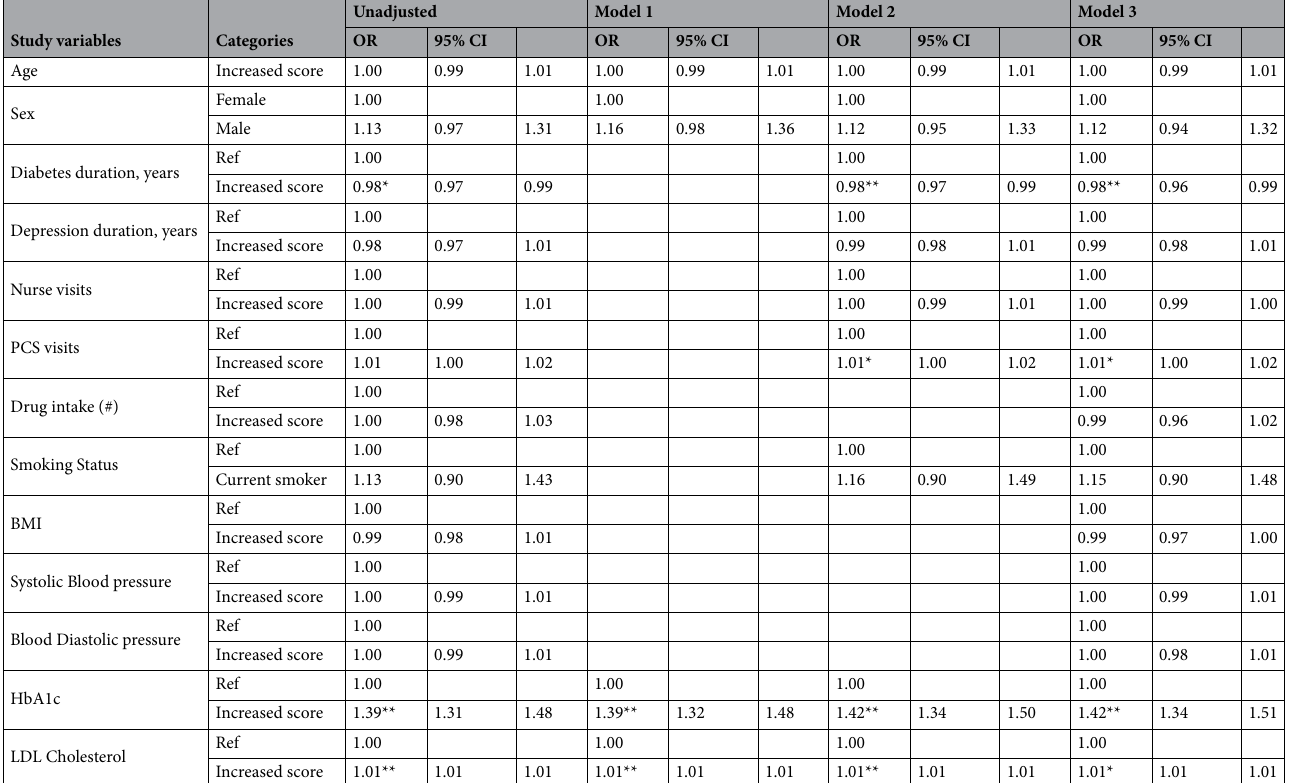
Table 2. Risk estimation for treatment nonadherence for primary DM outcomes and study covariates through hierarchical multivariate logistic regression models on diabetic patients with comorbid depression (N = 3340). Model 1 = Adjusted by age, gender, and primary DM outcomes (HbA1c and LDL Cholesterol). Model 2 = Model 1 + T2D duration (years), depression duration (years), nurse and PCS visits, and smoking status. Model 3 = Model 2 + # drug intake, BMI, systolic blood pressure, diastolic blood pressure. * p < .05; ** p <